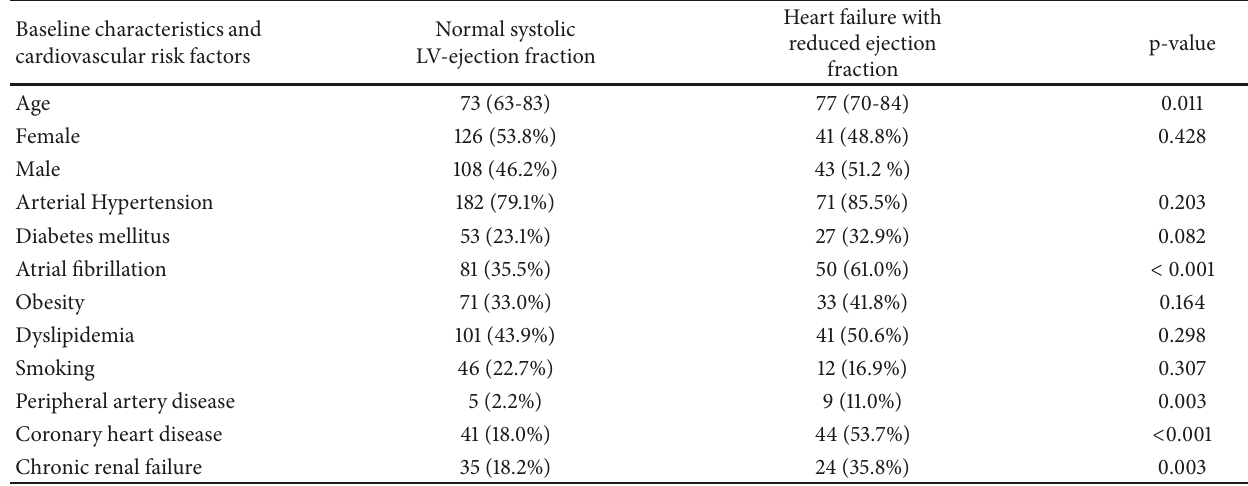
Table 1: Baseline characteristics of patients with and without heart